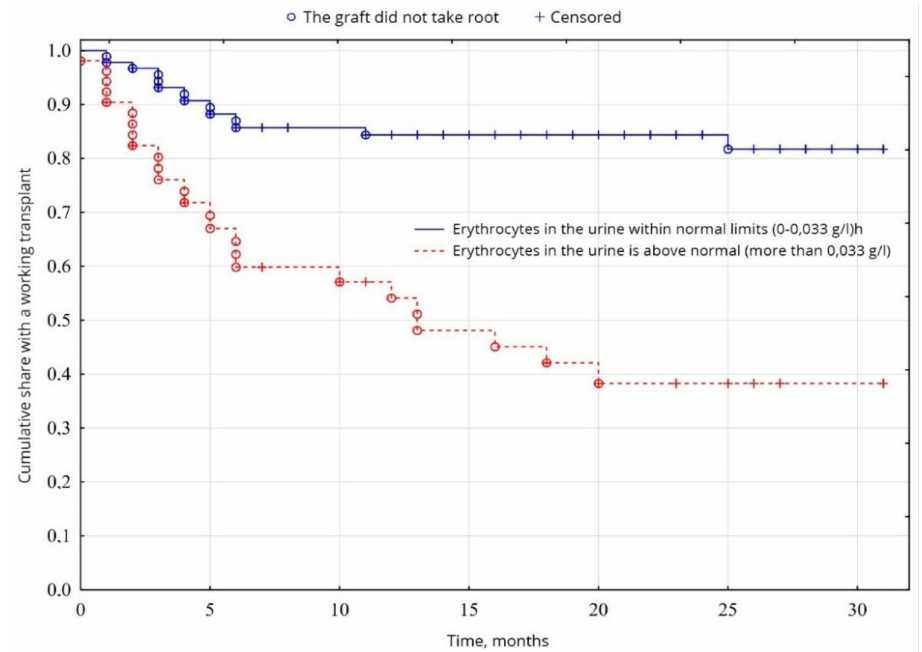
Figure 8. Evaluation of graft function depending on